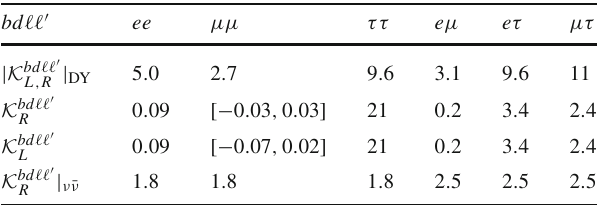
ranges are obtained from a global fit. LFV-bounds are quoted as